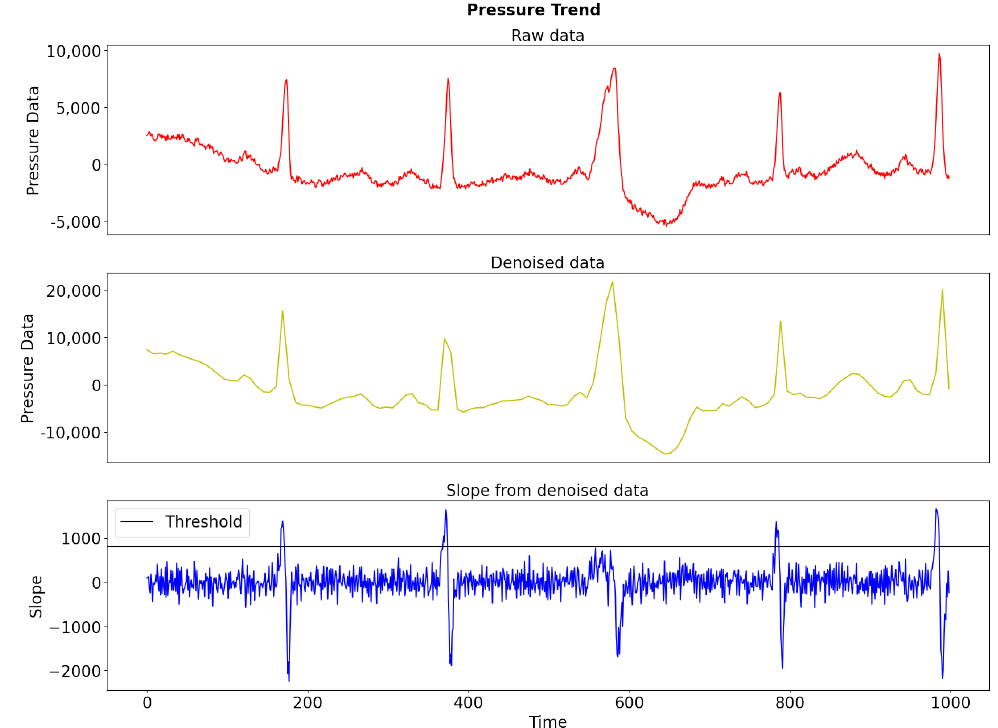
Figure 5. Detection of break points in detail data by the pressure trend